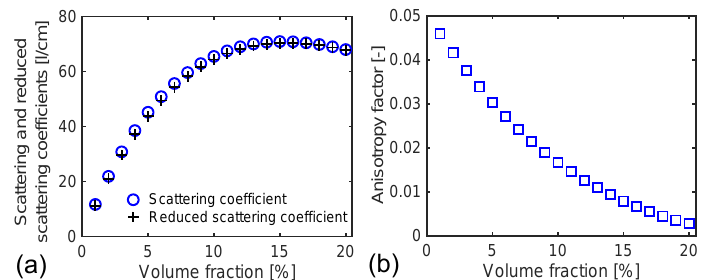
Figure 4. Scattering properties calculated from the DST for aqueous alumina suspensions at different volume fractions. ( a ) Scattering and reduced scattering coefficients and ( b ) anisotropy